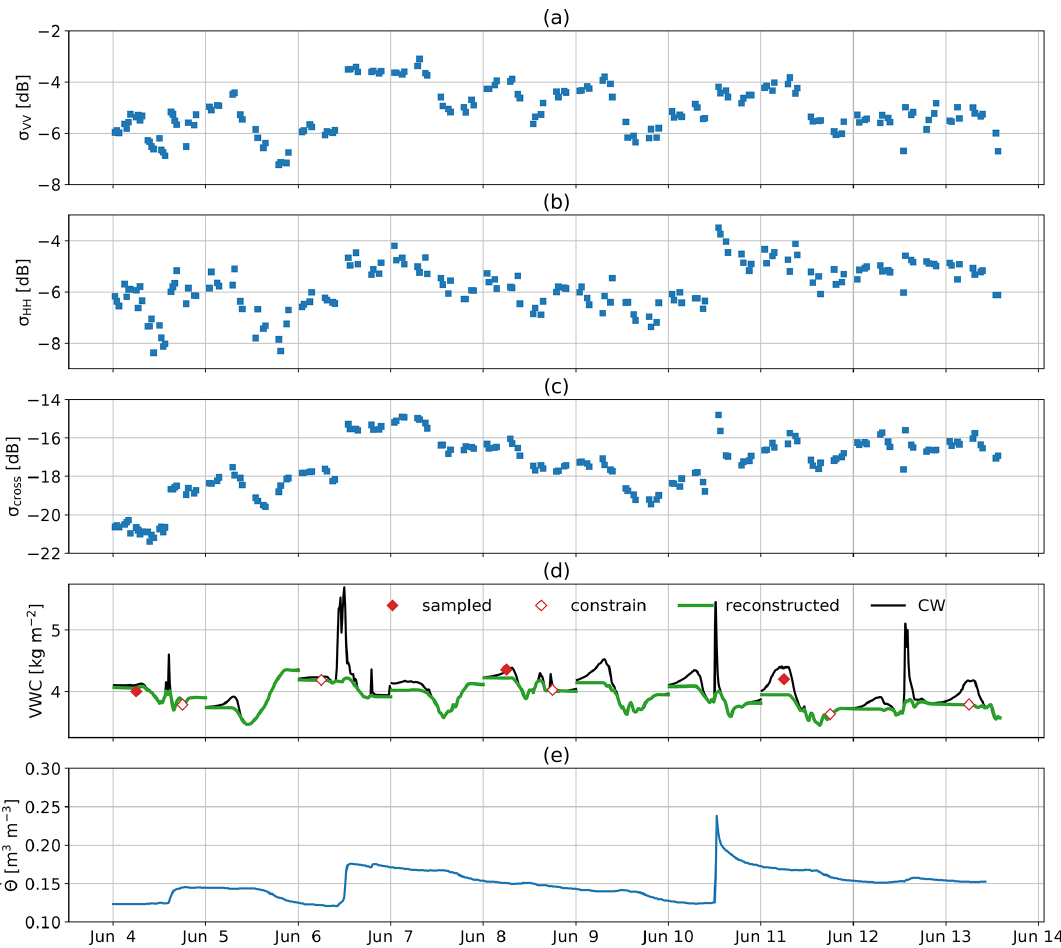
Figure 9. Full polarimetric L-band backscatter and separated effects for a 10d period near the end of the growing season in 2018, with (a) VV- polarized scattering coefficient, (b) HH-polarized scattering coefficient, and (c) averaged VH- and HV-polarized scattering coefficients, (d) sampled and reconstructed VWC, total canopy water, which is the sum of reconstructed VWC and SCW, and (e) soil moisture at 5cm depth. The measurements which are used to constrain the reconstructed line are accentuated with open markers.